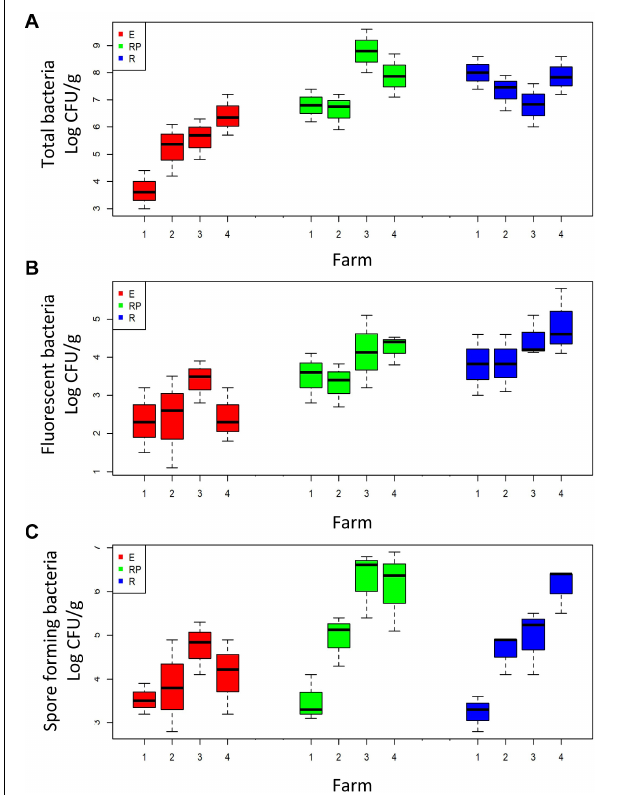
FIGURE 1 | Boxplot of the total (A) , fluorescent (B) , and spore-forming (C) cultivable bacteria in the three root compartments: rhizosphere (R, in red), rhizoplane (RP, in green), and endorhizosphere (E, in blue). Bacteria are grouped according to the farm on which they were collected ( x -axis).